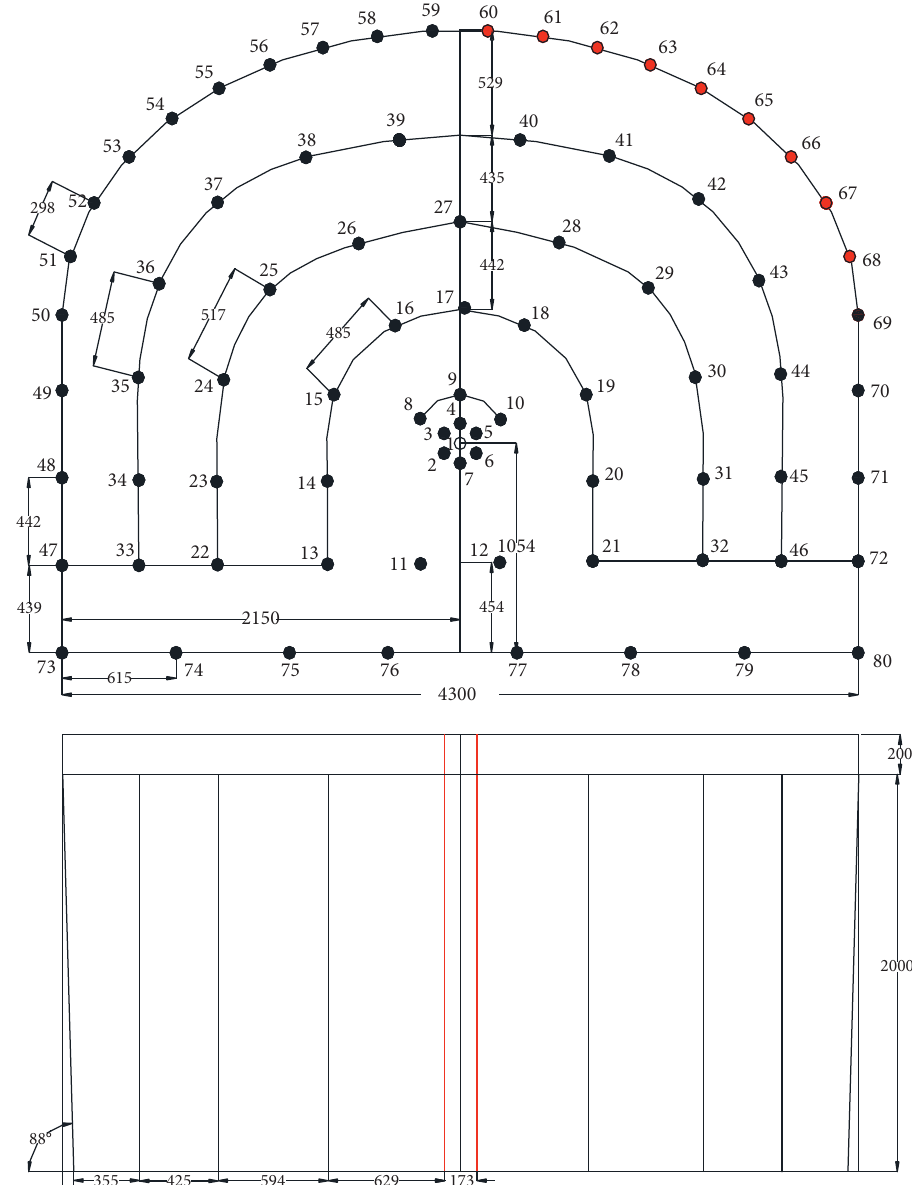
Figure 2: Section view and longitudinal view of the blasting hole of the cutting seam cartridge technology.